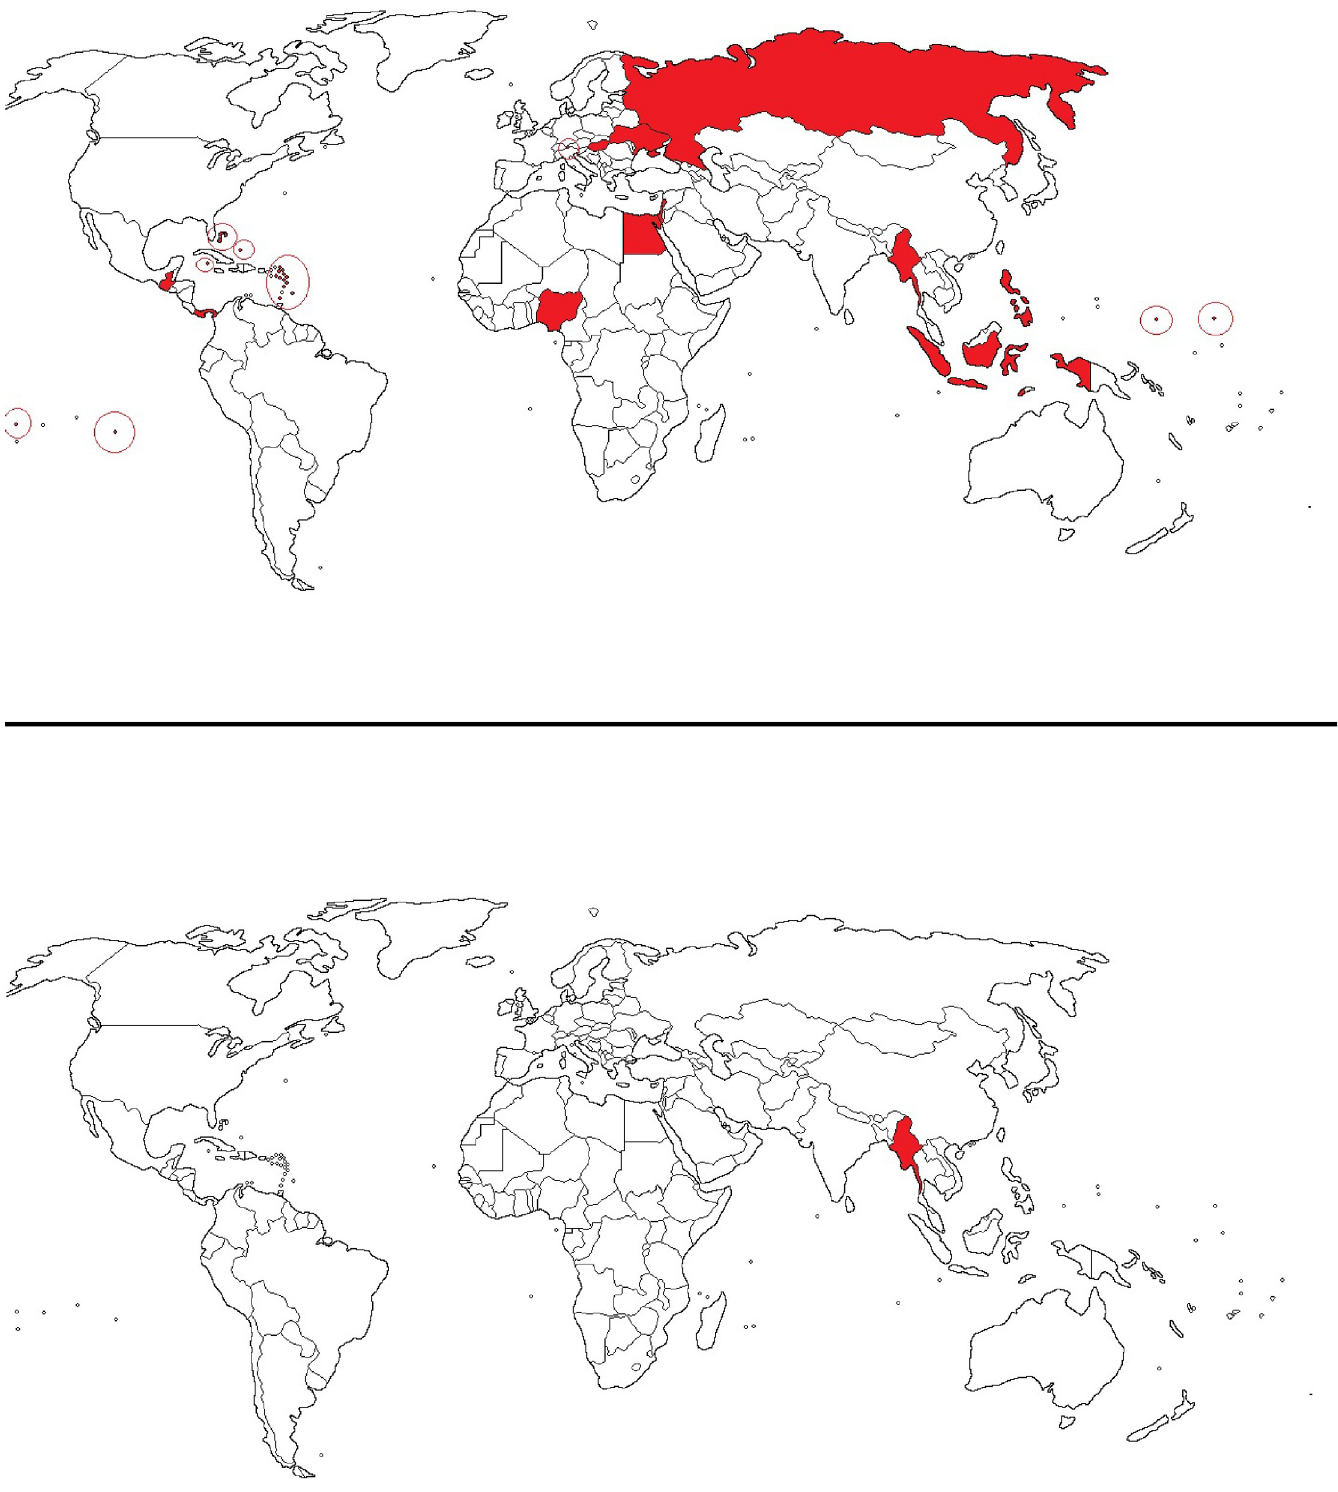
Fig 1. Blacklisted countries: 2000 and 2001 in the upper chart, 2006 in the lower chart. Blank map political world territories, shared under CC-BY-SA 4.0 license, altered for illustrative purposes. The blacklisted countries in 2000 and/or 2001 included: Egypt, Nigeria, Cook Islands, Indonesia, Myanmar, Marshalls lands, Nauru, Niue, Philippines, Hungary, Liechtenstein, Russia, Ukraine, Israel, Lebanon, Bahamas, Cayman Islands, Dominica, Grenada, Guatemala, Saint Kitts and Nevis, Panama and Saint Vincent and the Grenadines. Blacklisted in 2006: Myanmar.